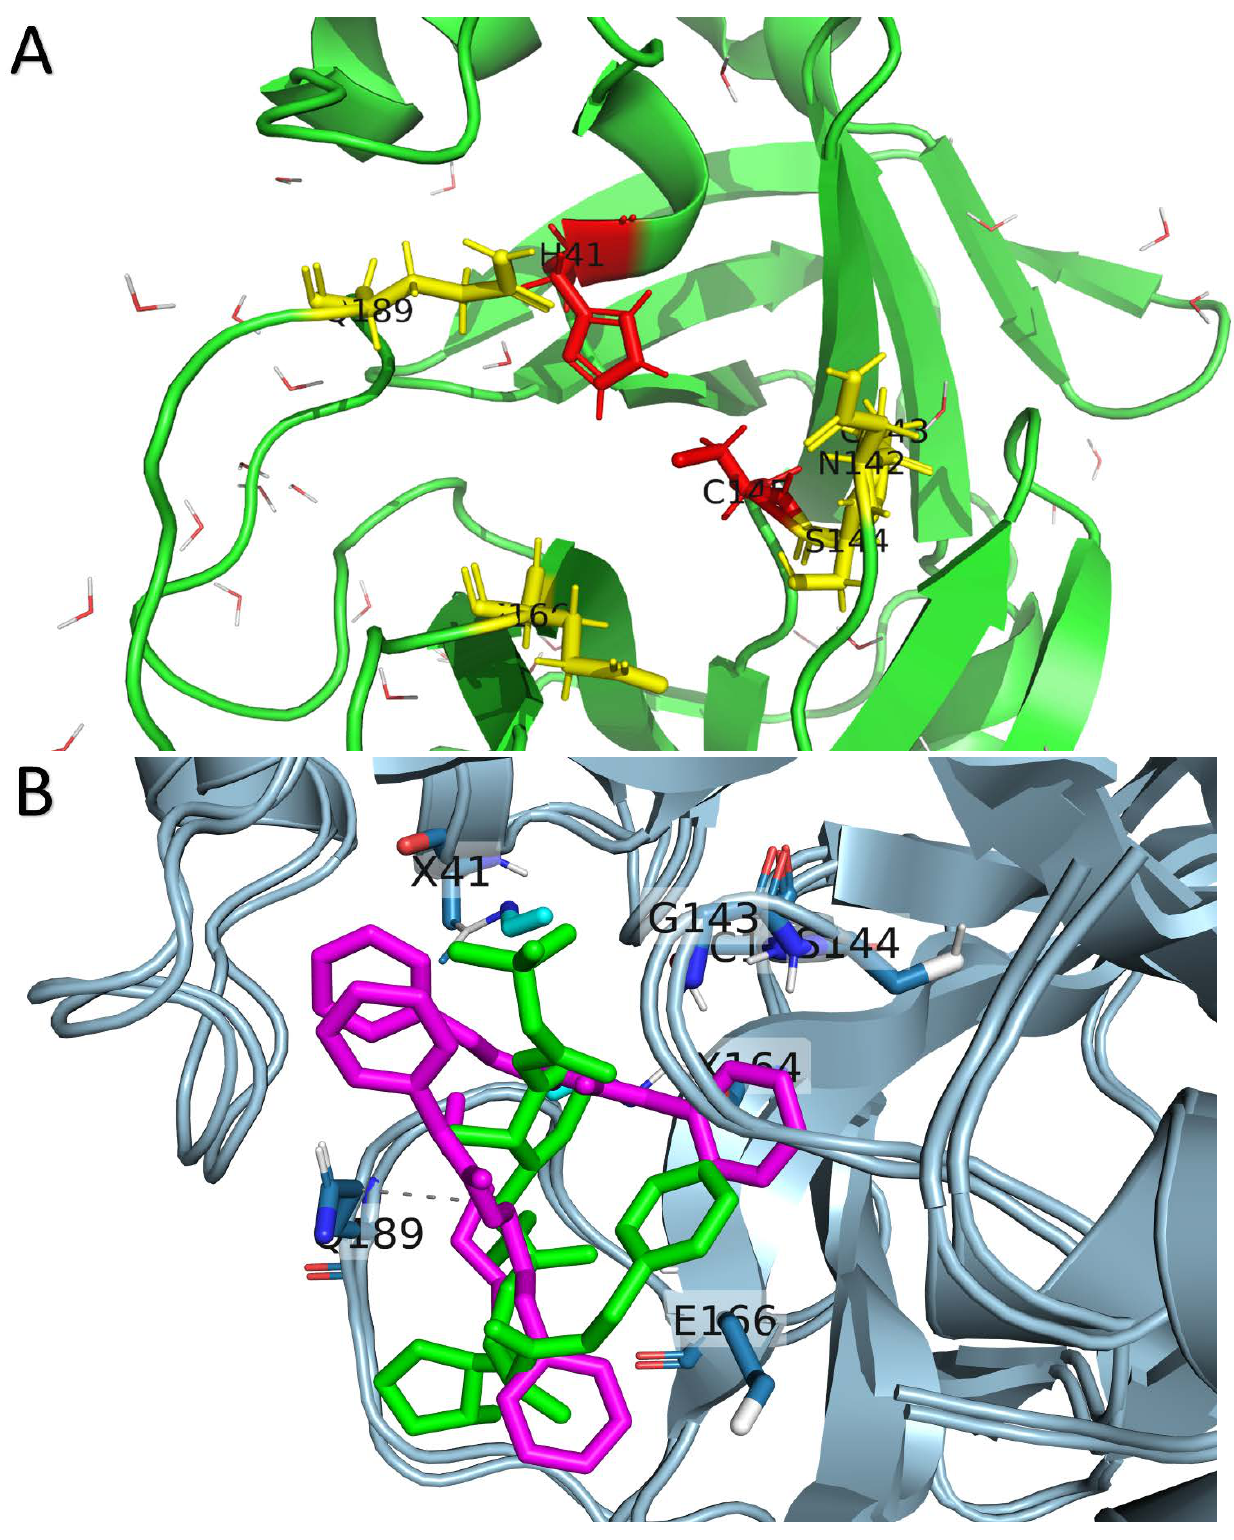
Figure 3. ( A ) The most reported interacting residues of SARS-CoV-2 Mpro (green cartoon) with the ligands are represented using the solved structure (PDB ID: 6LU7). The active site dyads (H41 and C145) are represented by red sticks, while the yellow sticks represent the most reported interacting residues, N142, G143, S144, E166, and Q189 (underlined in Table 1). ( B ) The superposition of the M pro (blue cartoon) is complexed with O6K (green sticks) and 5h (magenta sticks) for comparison. The active site pocket residues are labelled with its 1-letter codes.